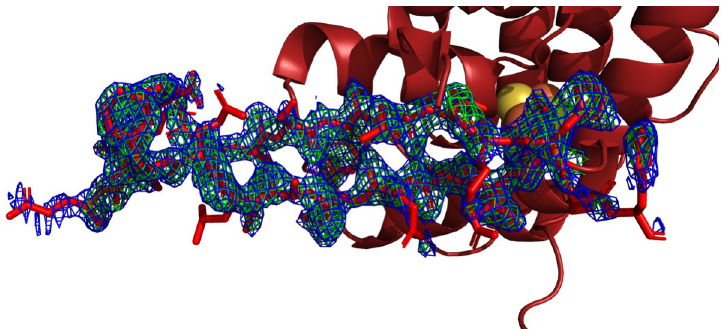
Fig 2. Electron density maps revealing β -sheet-like conformation for residues Leu318-His351. The ribbon diagram of the structure with Leu318-His351 displayed in stick representation is docked into the starting electron density map around the β -sheet-like region. Blue mesh represents the 2F o -F c map contoured at 1 σ , Green mesh represents the F o - F c map, contoured at 3 σ . Figure made in Pymol using the isomesh command [33].